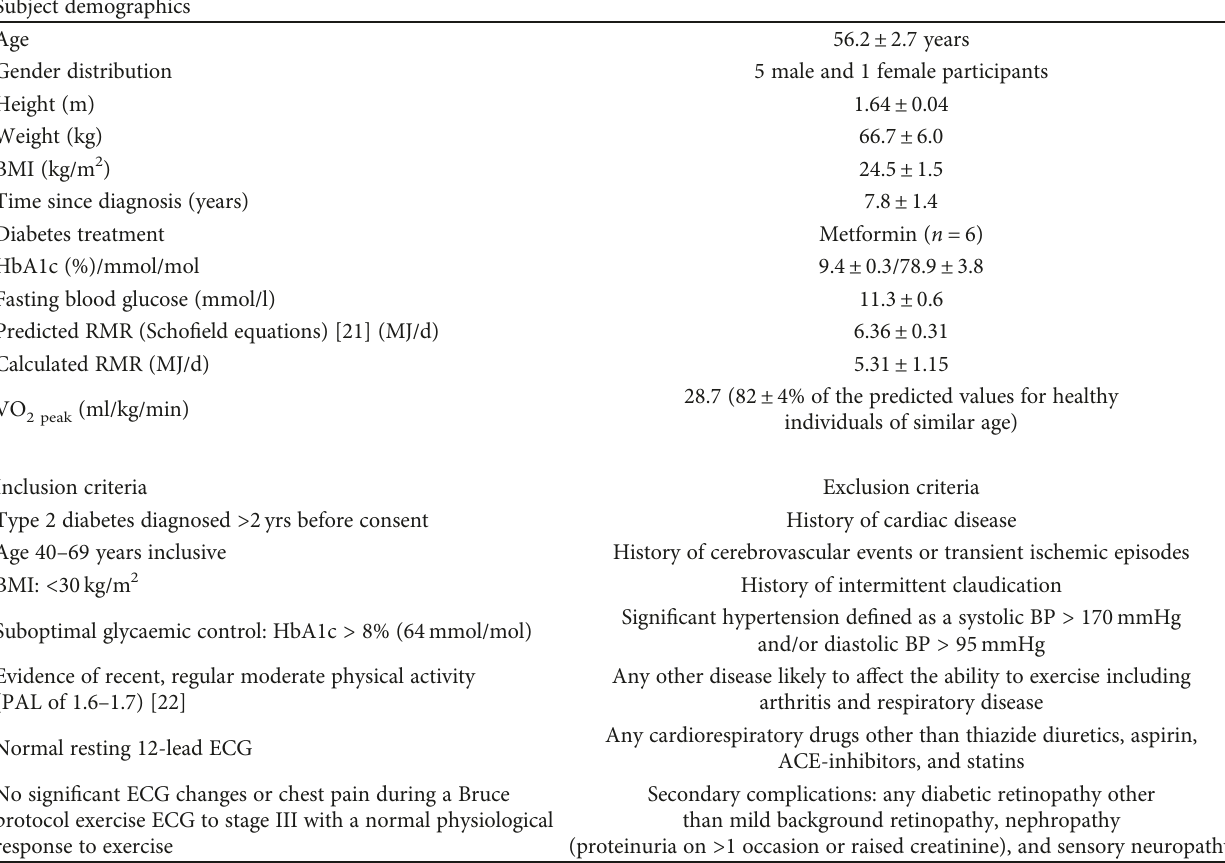
Table 1: Subject demographics and inclusion and exclusion criteria for